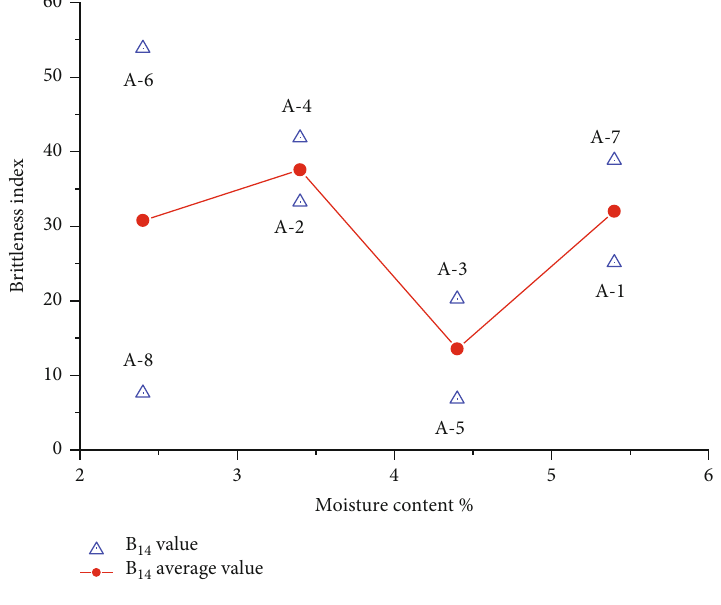
Figure 14: B under di ff erent moisture content. 14 Table 1: Summary of B values at di ff erent water content.